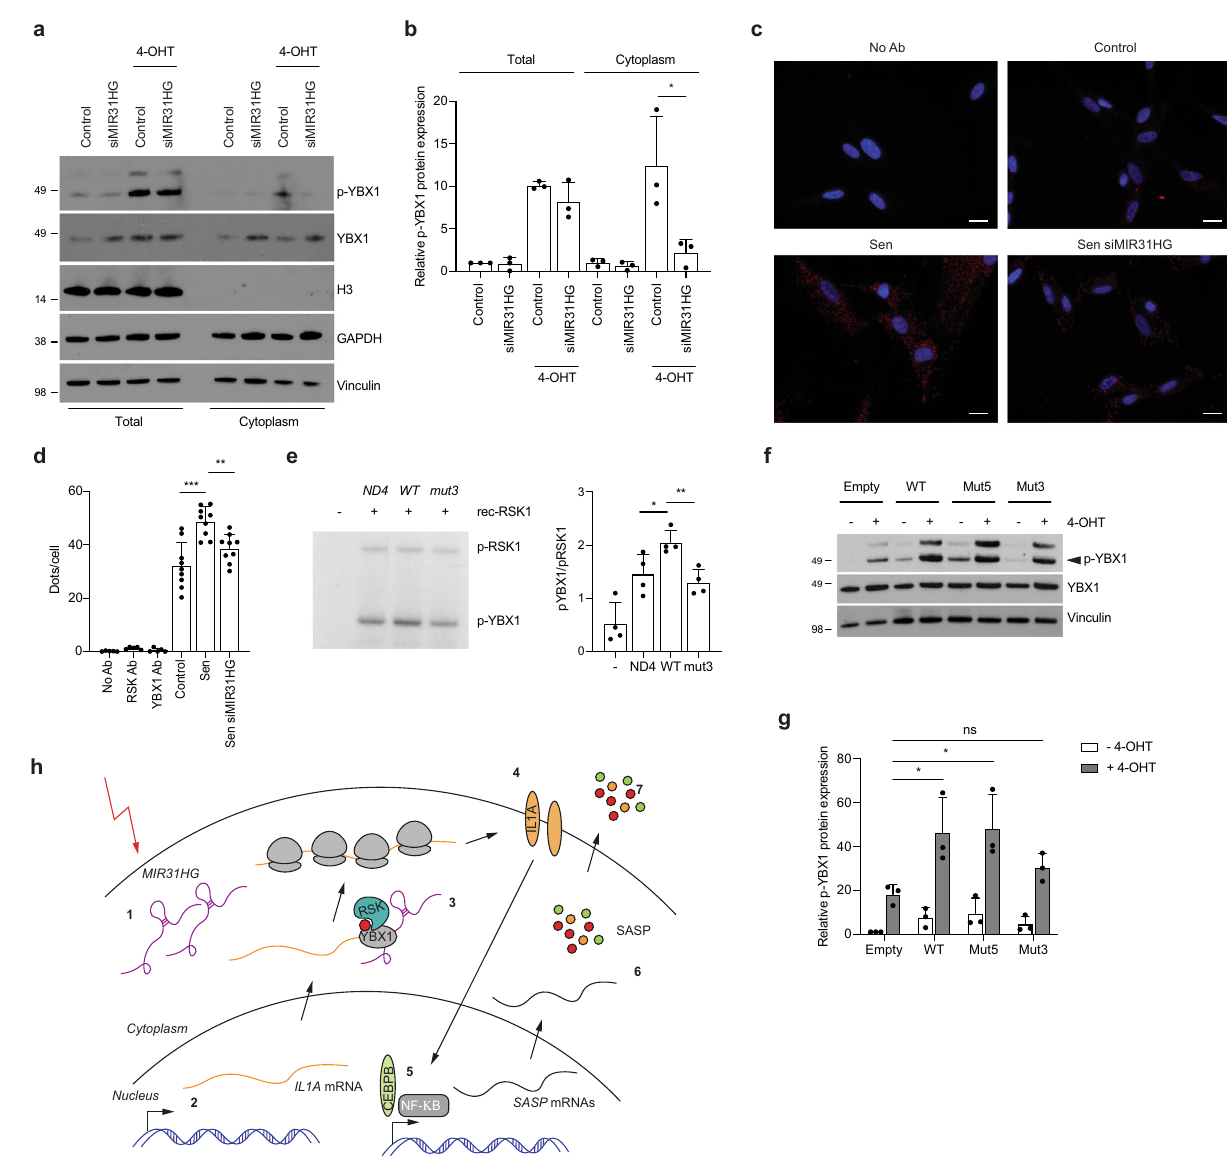
Fig. 6 MIR31HG promotes YBX1 phosphorylation by facilitating YBX1 interaction with its kinase RSK. a Western blot analysis for p-YBX1, total YBX1, GAPDH and H3 in total and cytoplasmic fractions of BJ ER:BRAF cells (Control or siMIR31HG1-2) treated with ethanol (Control) or 1 μ M 4-OHT for 72 h ( n = 3). b Quanti fi cation of the pYBX1 band intensities relative to total YBX1 and Vinculin from three independent experiments. c PLA representative images showing the interaction (red dots) between YBX1 and RSK in BJ ER:BRAF cells (Control or siMIR31HG1) were treated with ethanol (Control) or 1 μ M 4-OHT for 72 h. DAPI staining (blue) shows the nucleus. d Quanti fi cation of the number of interactions (dots) per cell in the conditions indicated in a representative experiment from four independent replicates ( n = 4). Scale bar: 20 μ m. e Left , in vitro kinase experiment incubating recombinant YBX1 in the presence of 32 P-ATP and recombinant RSK1 in the presence of the indicated in vitro-transcribed RNA, run in 4 – 12% NuPAGE Bis – Tris gel and exposed to an Amersham Hyper fi lm ECL fi lm. Right , quanti fi cation of the band intensities represented as p-YBX1 related to p-RSK ( n = 4). f Western blot for p-YBX1, total YBX1 and Vinculin in BJ ER:BRAF cells expressing a doxycycline-induced empty, MIR31HG WT, Mut3 or Mut5 treated for 36 h with ethanol (Control) or 1 μ M 4-OHT. g Quanti fi cation of the p-YBX1 band intensities relative to total YBX1 and Vinculin ( n = 3). h Scheme of the working model: (1) During OIS MIR31HG is induced and locates in the cytoplasm. (2) At the same time, transcription of IL1A mRNA is induced. (3) IL1A mRNA is exported to the cytoplasm where it interacts with YBX1. MIR31HG facilitates YBX1 interaction with the kinase RSK promoting its phosphorylation which in turns promotes IL1A translation. (4) IL1A signalling induces the transcription of other SASP mRNAs through CEBPB and NF- κ B. (5) These RNAs will be translated in the cytoplasm and the SASP components will be secreted (6). Statistical signi fi cance was calculated using two-tailed Student ’ s t -tests, * p < 0.05; ** p < 0.01; *** p < 0.001. Error bars represent means ± s.d. Source data are provided as a Source Data fi